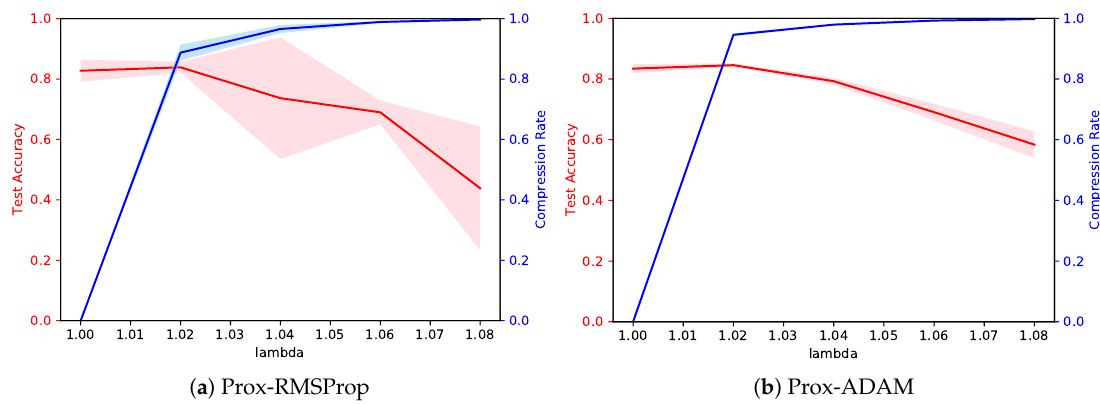
Figure 5. Comparison of our suggested algorithms ( a ) Prox-RMSProp and ( b ) Prox-ADAM, on VGGNet training with the CIFAR-10 dataset. Prox-ADAM produced more stable trained models in terms of test accuracy and compression